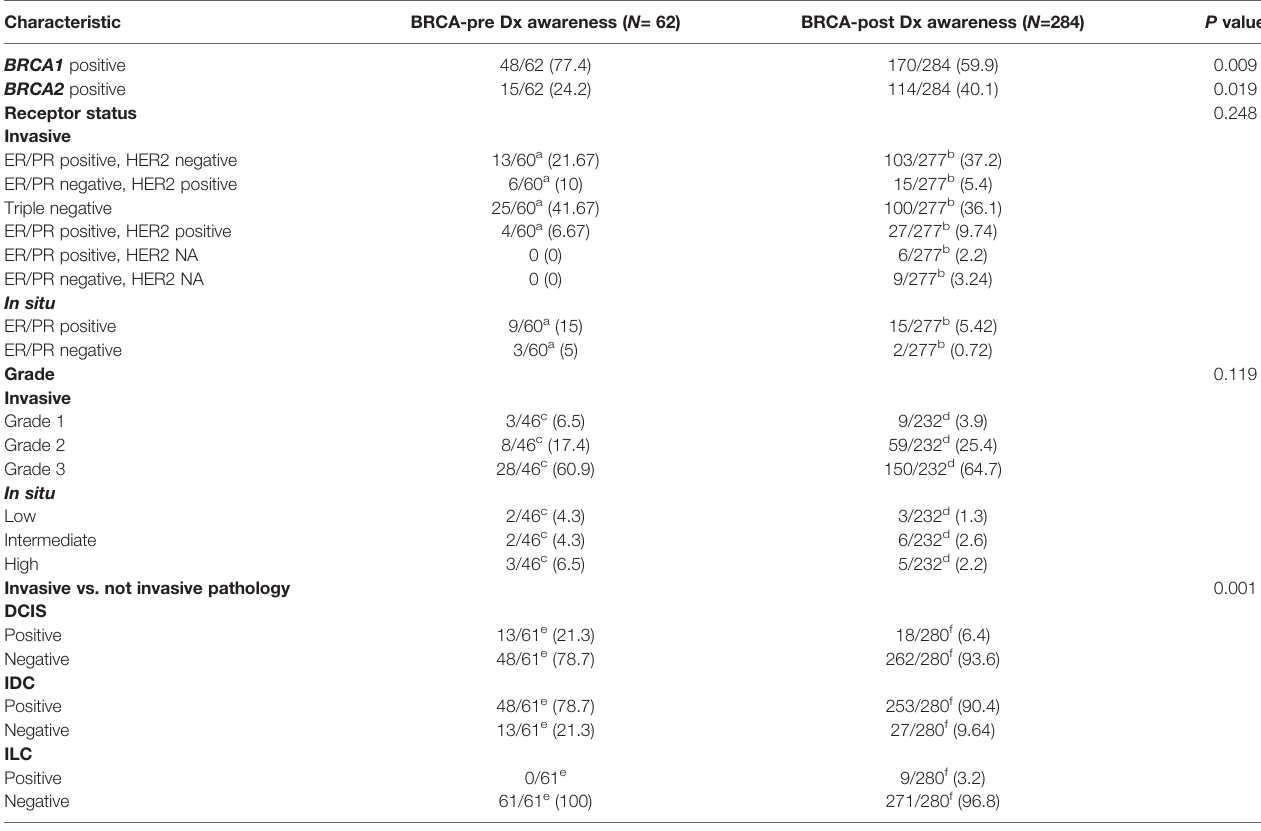
TABLE 2 | Breast tumor characteristics.